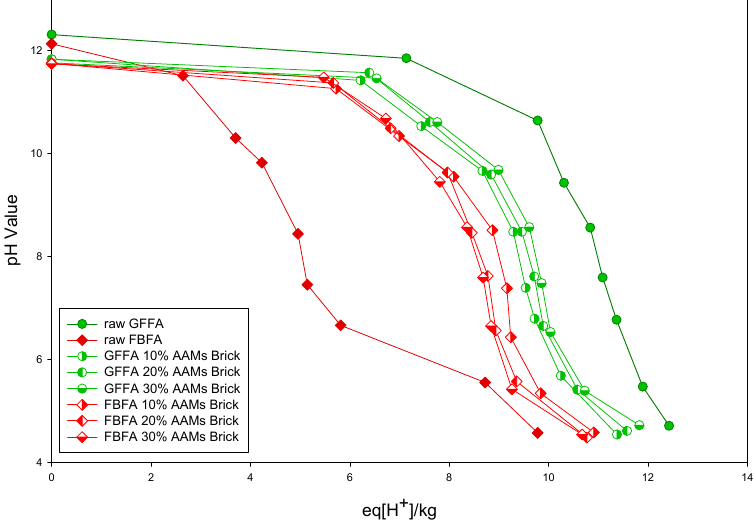
Figure 3. The acid neutralizing capability curves of raw GFFA/FBFA and municipal solid waste incineration fly ask (MSWI-FA) containing AAMs bricks.